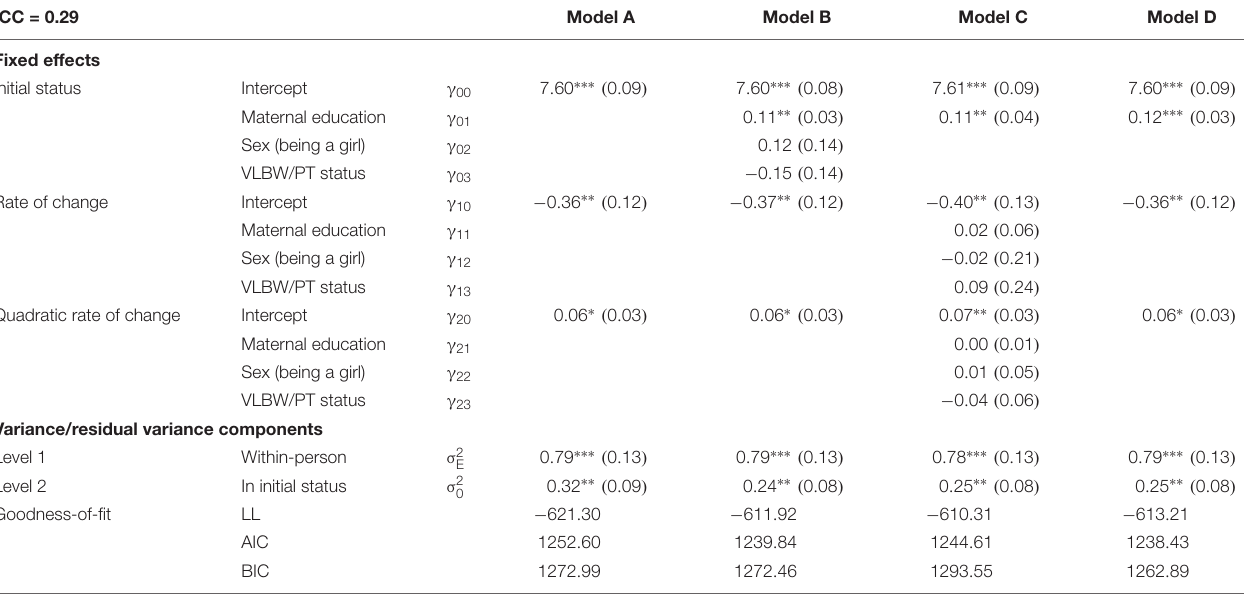
TABLE 3 | The growth models of maternal sensitivity between 6 and 57 months. ICC = 0.29